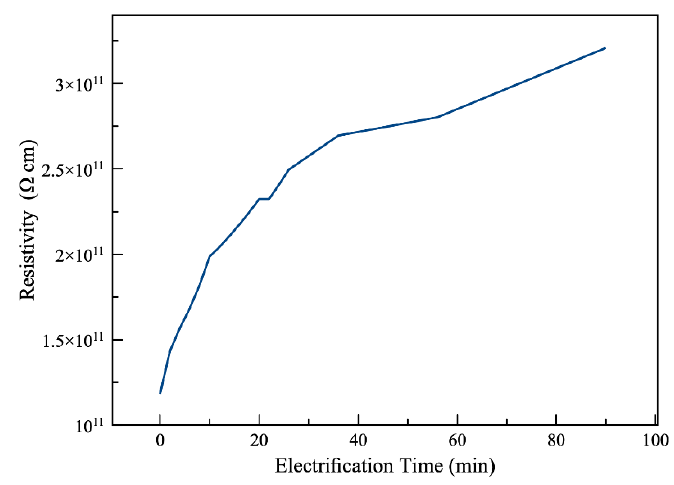
Figure 3. Volume resistivity with respect to time of a Viton sample under constant 500 V DC (less than 1% error).